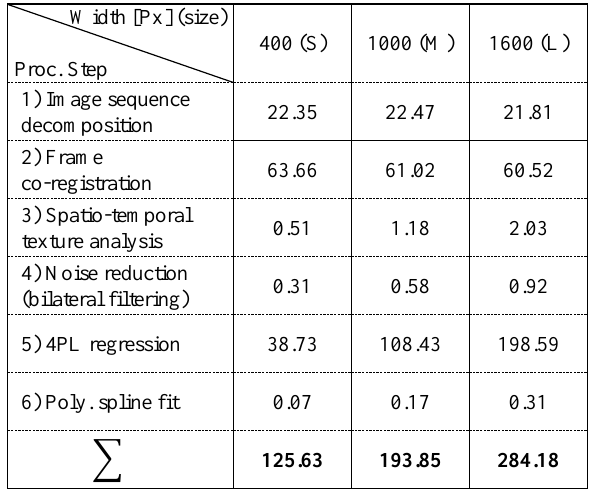
Figure 9: Relationship of the single processing steps and their corresponding computation times in [s] in matters of image size.